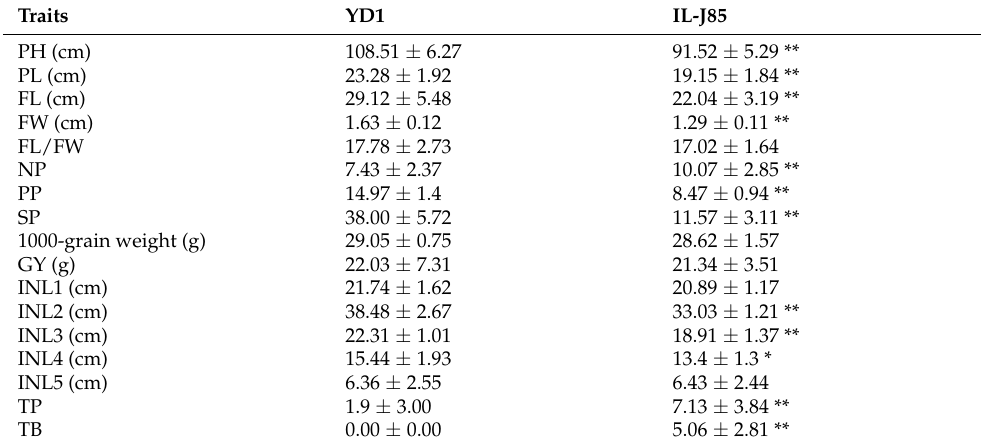
Table 1. Investigation of agronomic traits in YD1 and IL-J85. Traits